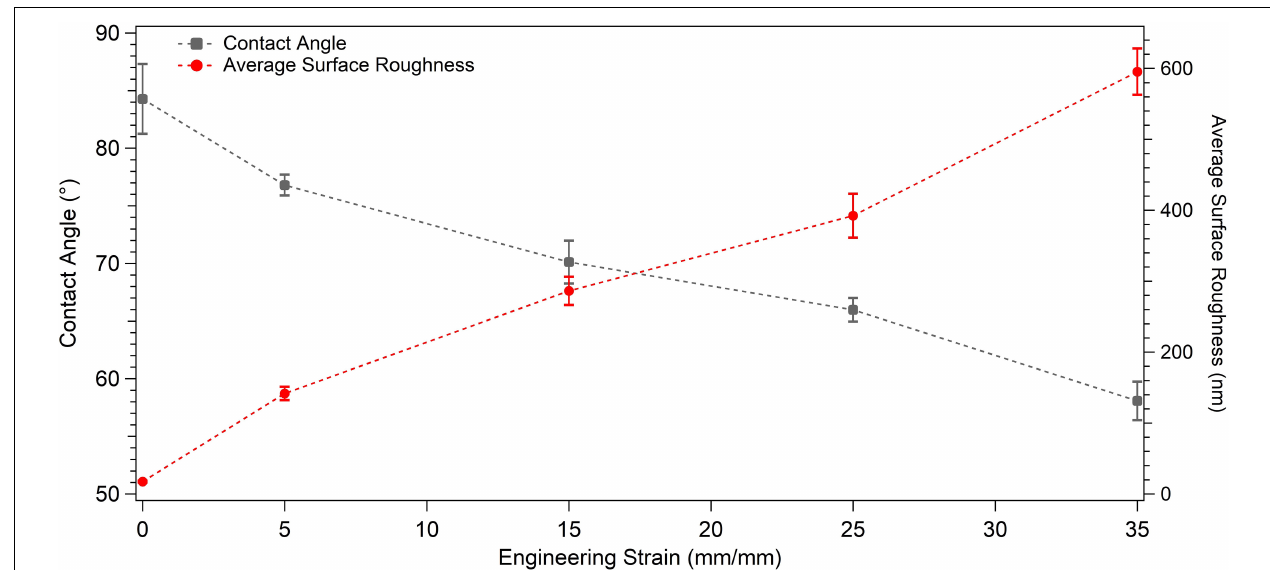
FIGURE 5 | Graph presenting the water contact angle and average surface roughness values of the undeformed and plastically deformed